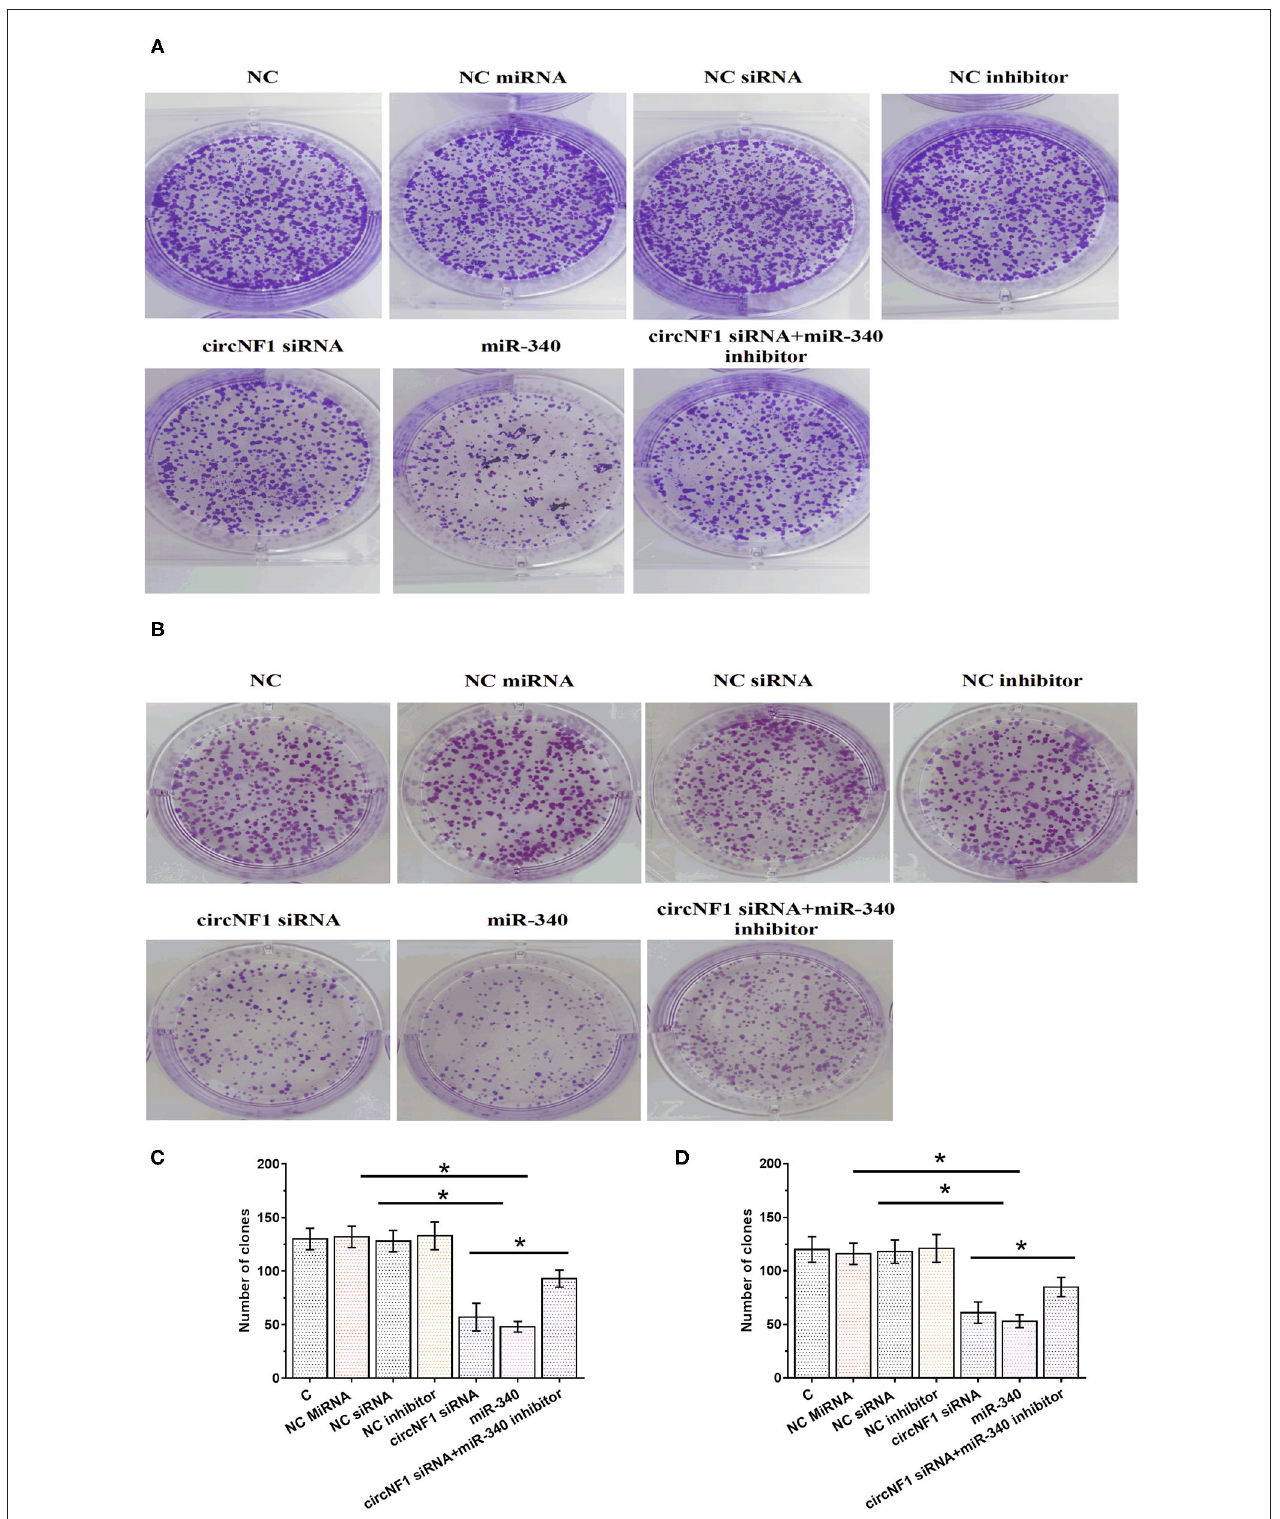
FIGURE 6 | circNF1 siRNA suppressed the proliferation of glioblastoma cell through miR-340. Clone formation assay was performed to analyze the role of circNF1 and miR-340 in regulating the proliferation of U-138 (A,C) and U-87 cells (B,D) . Data from cell transfection experiments were expressed as mean ± SD values of three biological replicates, and data comparisons were performed by ANOVA Tukey’s test. * p < 0.05.